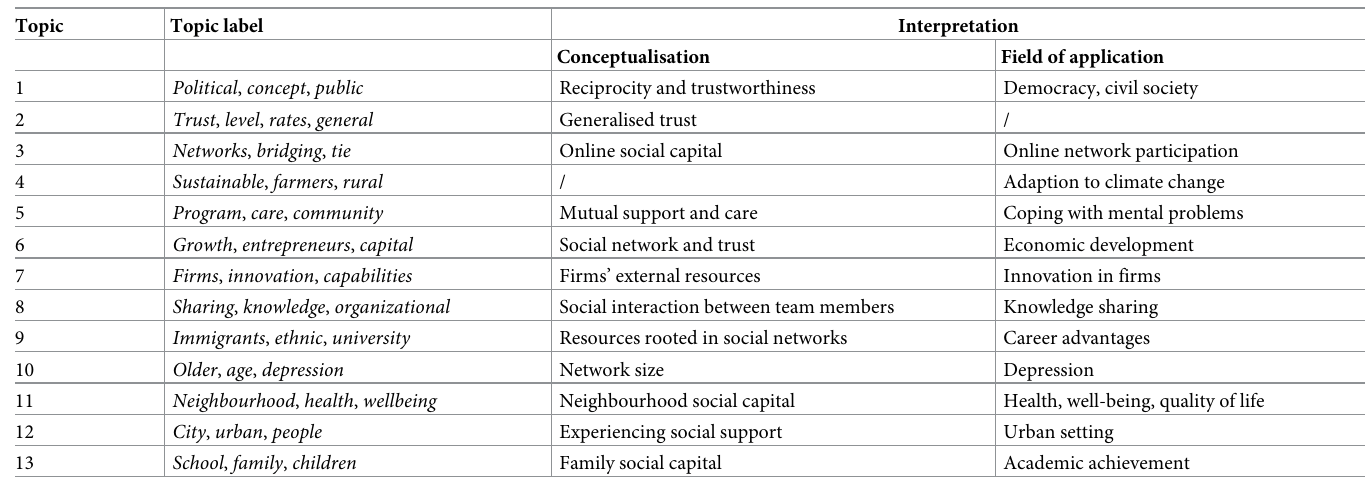
Table 2. Summary of the interpretations of the topic